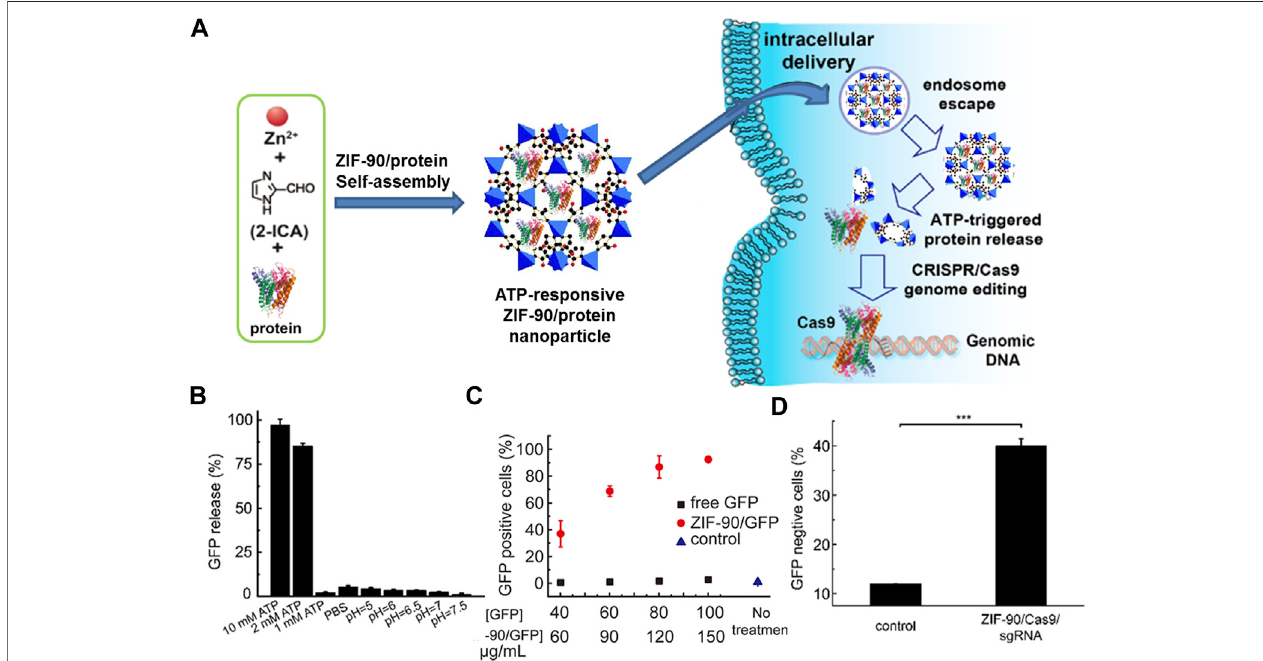
FIGURE 4 | (A) The schematic illustration of the self-assembly of ZIF-90/protein and ATP-triggered protein release from ZIF-90 inside cells. (B) Selectivity of ATP triggered protein release from ZIF-90/GFP. (C) Cellular uptake ef fi ciency ofZIF-90/GFPbyHeLacells. (D) ThedeliveryofZIF-90/Cas9ef fi ciently inhibits GFP expression of HeLa-GFP cells. HeLa-GFP cells were treated with ZIF-90/Cas9 nanoparticles (120 nM Cas9) alone with 60 nM sgRNA. Source: (Yang B et al., 2019).